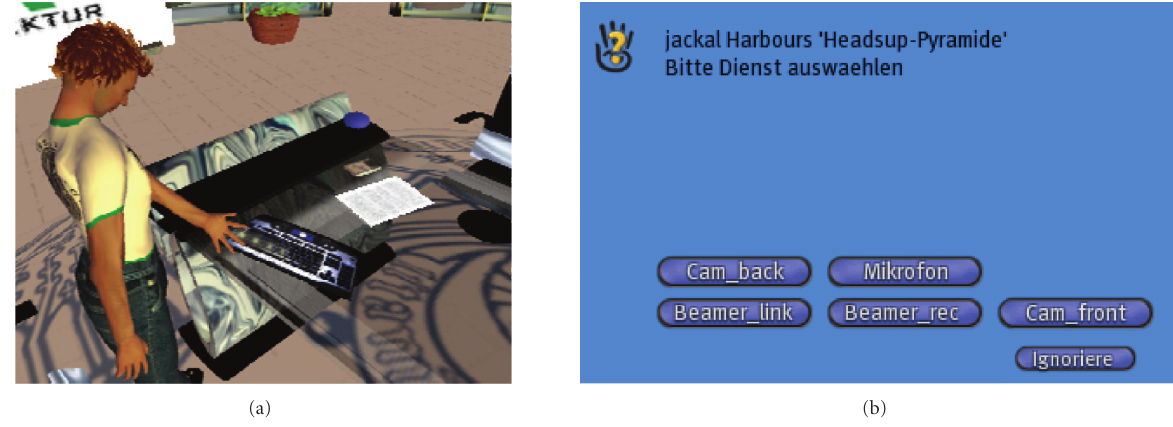
Figure 4: As an additional 3D element that attracts the user’s attention a keyboard encapsulates interaction with invisible objects and non- 3D, dialogue-based interaction (e.g., for controlling the technical equipment of the real-life media-lab).